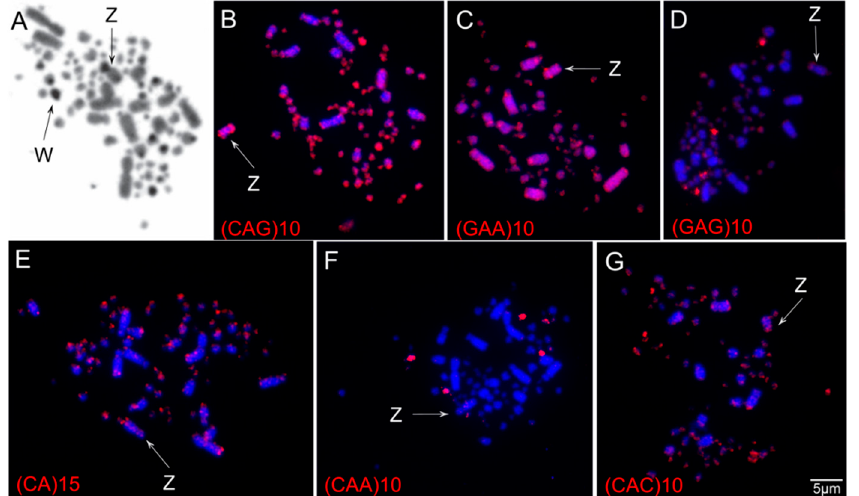
Figure 2. C ‐ banding patterns ( A ) and hybridization of simple short repeats ( B – G ) onto metaphases of a female individual of Sicalis flaveola . The chromosome probes used are indicated on the left bottom, and the sex chromosomes (Z and W) are indicated by arrows.